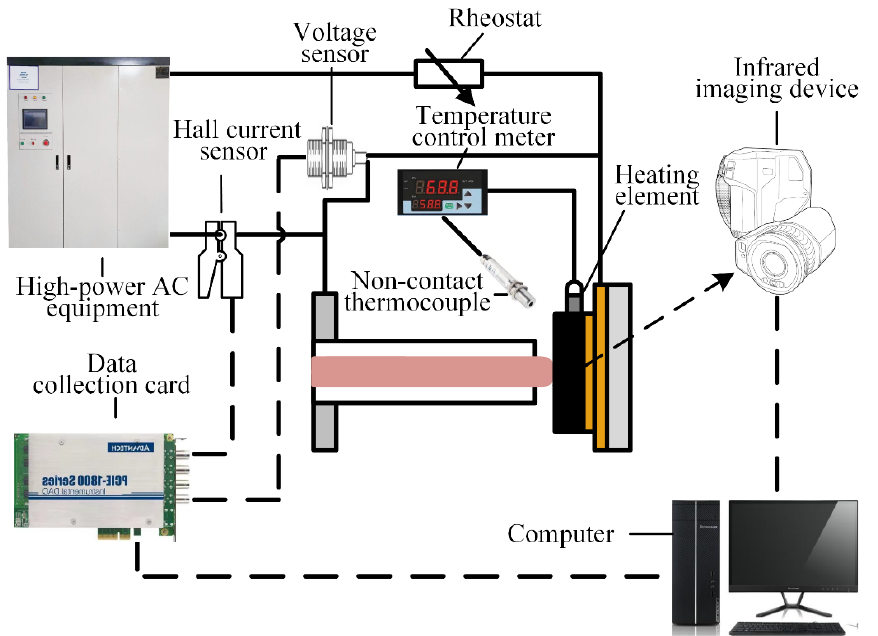
Figure 2. Schematic diagram of data acquisition and temperature control system.